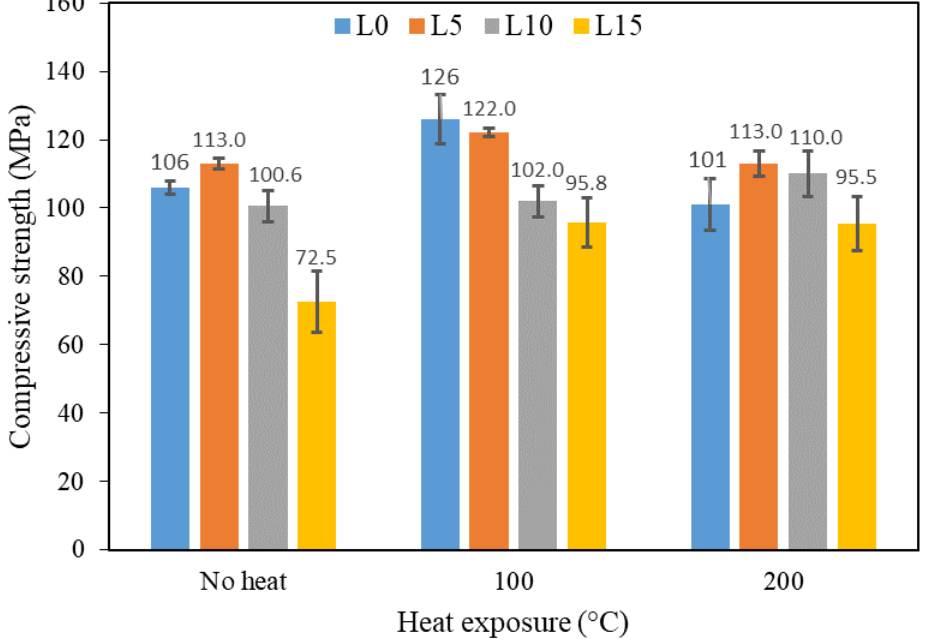
Figure 4. Compressive strength of UHPC